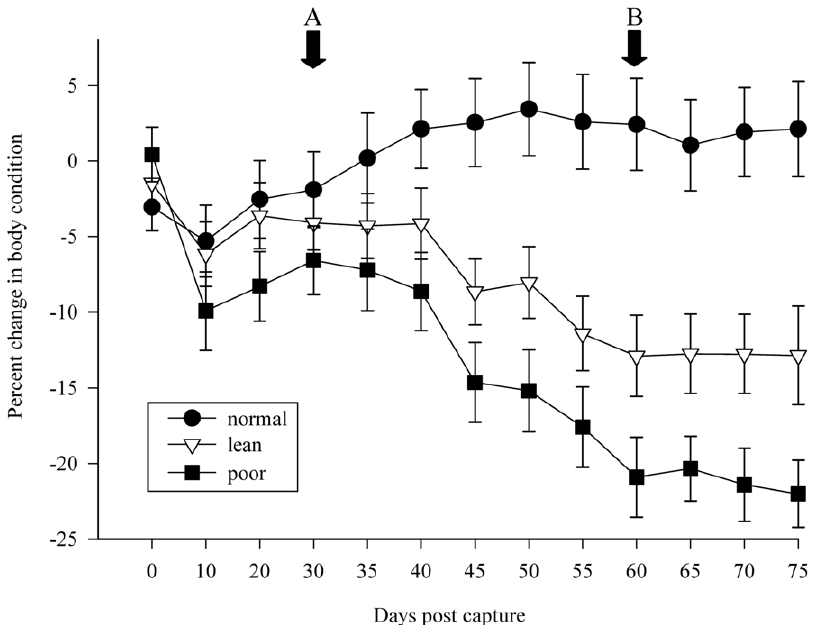
Figure 2. Body condition for wild mallard treatment groups throughout the study. Data points represent mean condition ( 6 1 standard error), A=start of diet manipulation, B=LPAIV H5N9 inoculation.